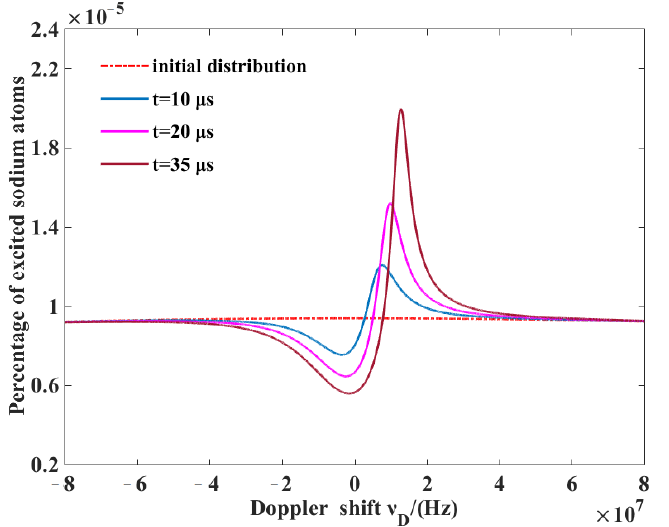
Figure 2. Normalized distributions of sodium atoms with recoil at t = 10 µ s, 20 µ s, and 35 µ s for 0 MHz